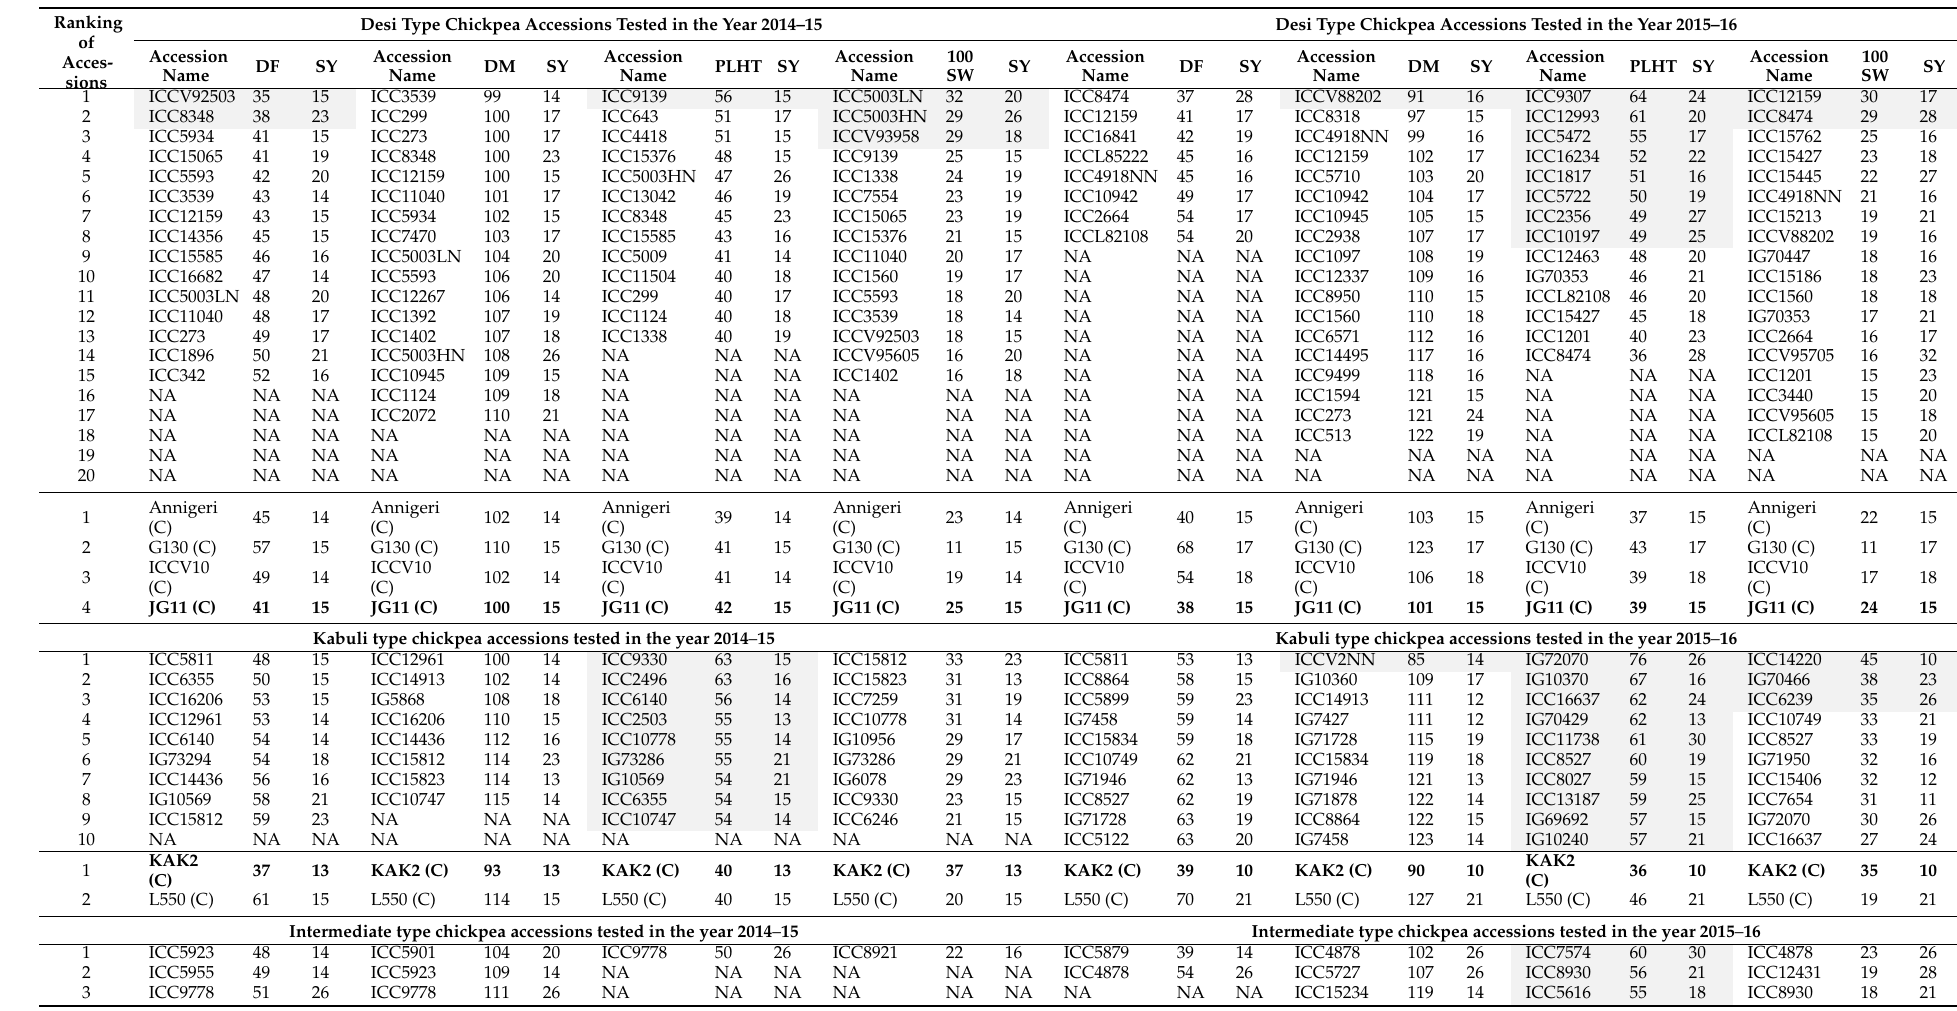
Table 4. Shortlisted germplasm accessions based on ranking biplot for five traits across two years for Patancheru,